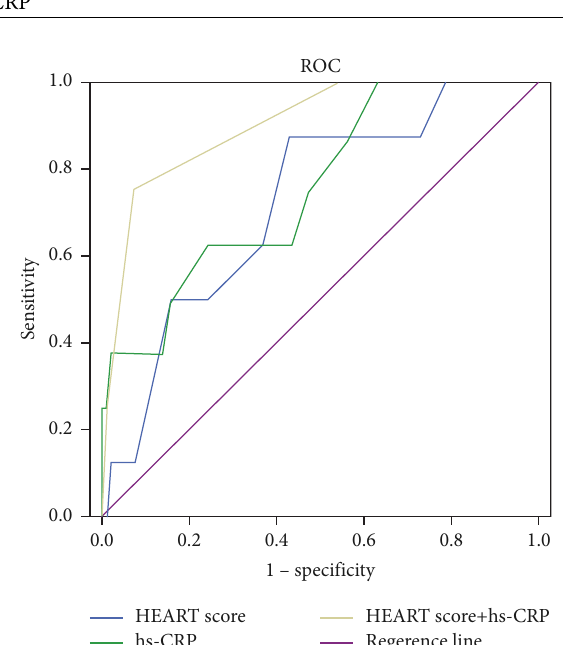
Figure 1: Predictive value of diferent indicators for 30d MACE in patients with acute chest pain (the ROC curve above the reference line represented its diagnostic value, and the closer the curve to the upper left corner of the graph, the greater the diagnostic